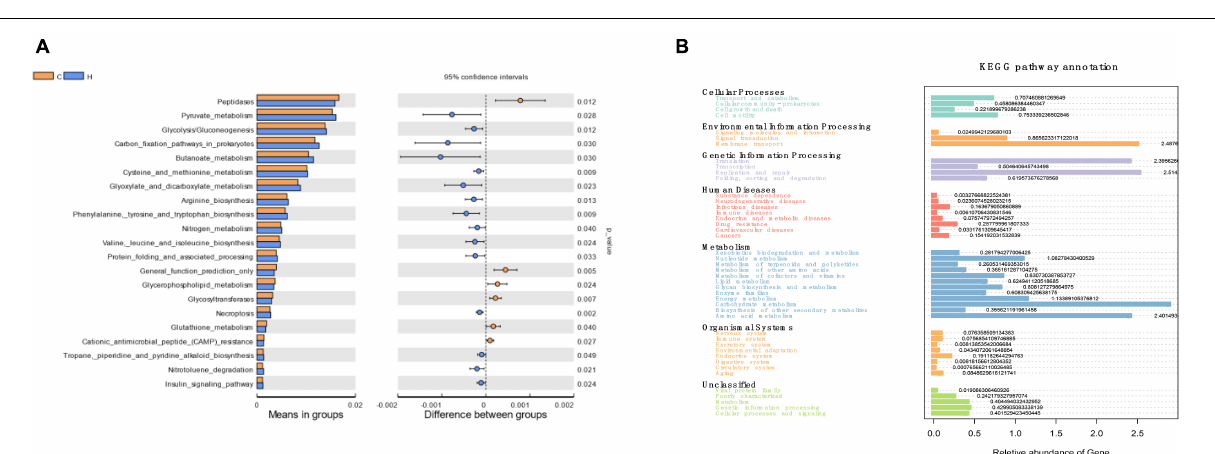
FIGURE 4 | The KEGG pathway affected by HS in rabbits. (A) The KEGG levels 1 and 2; (B) KEGG level